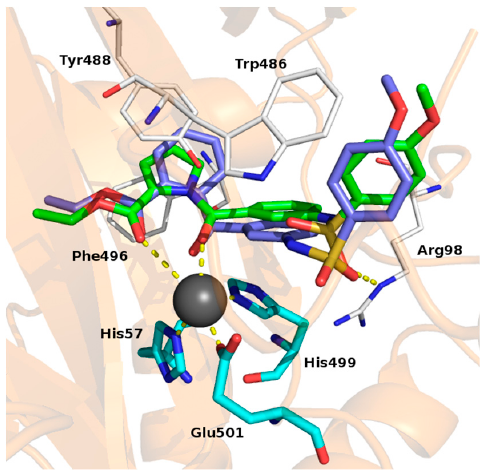
Figure 1. Proposed binding mode for RS3195 (green) and RS5033 (magenta). The iron atom is reported as grey sphere; the coordinating residues are depicted as cyan sticks and the coordination bond as yellow dot lines. The residues involved in interactions with the inhibitors are reported as white lines. H-bond is reported as yellow dot lines.